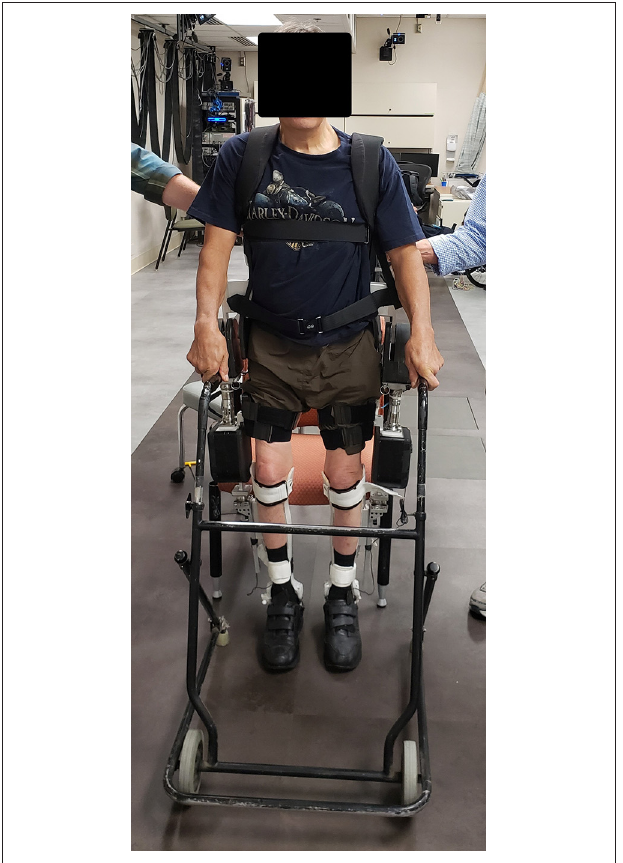
FIGURE 6 | Participant with SCI standing with hybrid